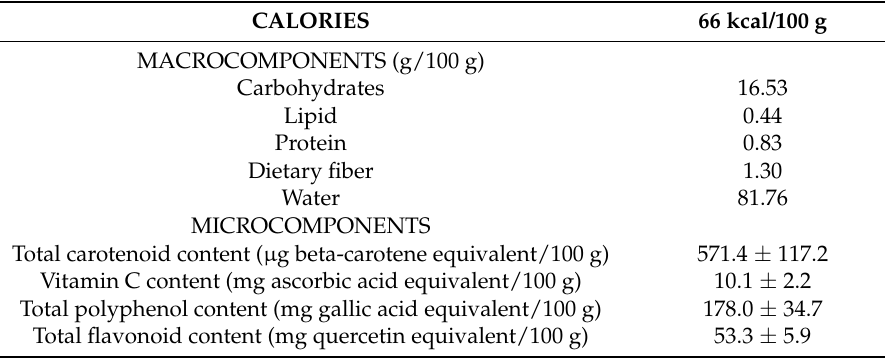
Table 1. Principal macronutrients and micronutrients of Litchi fruit.